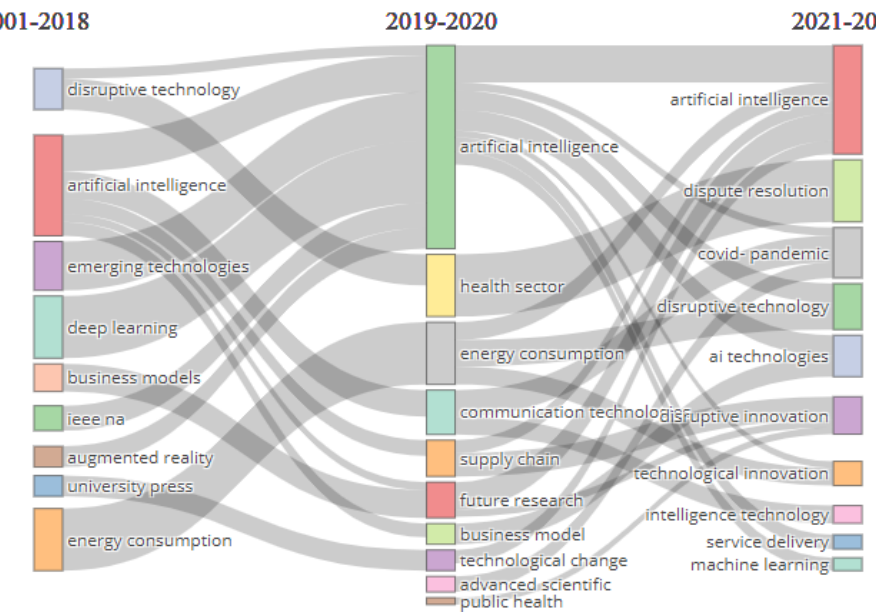
Figure 7. Thematic evolution of topics for the selected articles (n = 97).